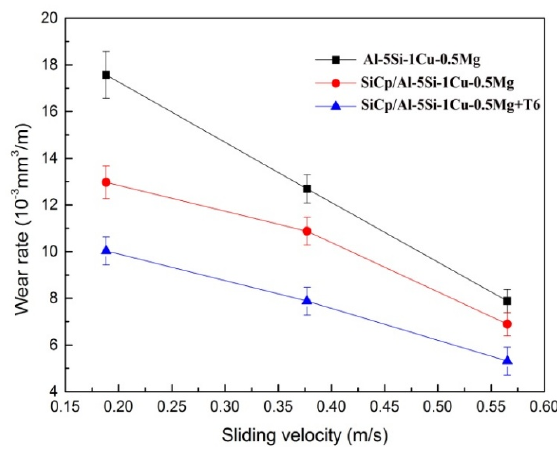
particles and Al 2 Cu phase could act as effective barriers to dislocation motion during subsurface deformation, which increased the rate of work ‐ hardening. It can be considered as the main mechanism of the wear behavior improvement. So, when added with SiCp, Al ‐ 5Si ‐ 1Cu ‐ 0.5Mg alloy Figure 6. Wear rate values for samples at various Sliding velocity under a normal load of 60 N. achieved a lower wear rate when compared with the one of the base alloy, and after T6 treatment, the wear rate value decreased further. It has been recognized that under the condition of sliding with loading, strain hardening will be developed. The higher the sliding speed, the more pronounced the hardening of the alloy. SiCp